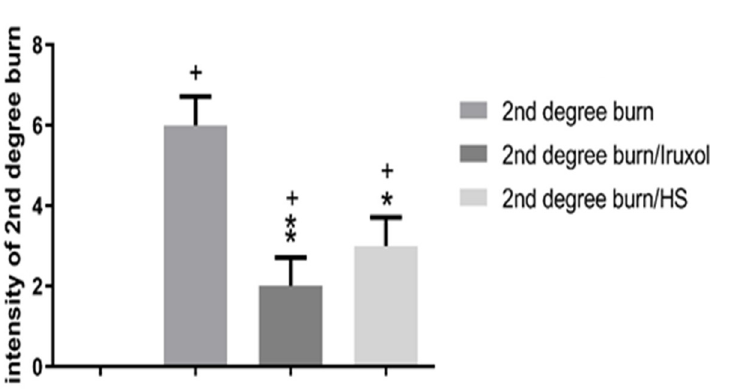
Figure 1. Intensity of 2nd degree burn in different groups. HS: Hibiscus sabdariffa , +, p < 0.05 vs. normal group; *, p < 0.05 vs. 2nd degree burn group; **, p < 0.01 vs. 2nd degree burn group. Differences between groups were examined by Kruskal-Wallis followed by Dunn’s multiple comparison test. n =